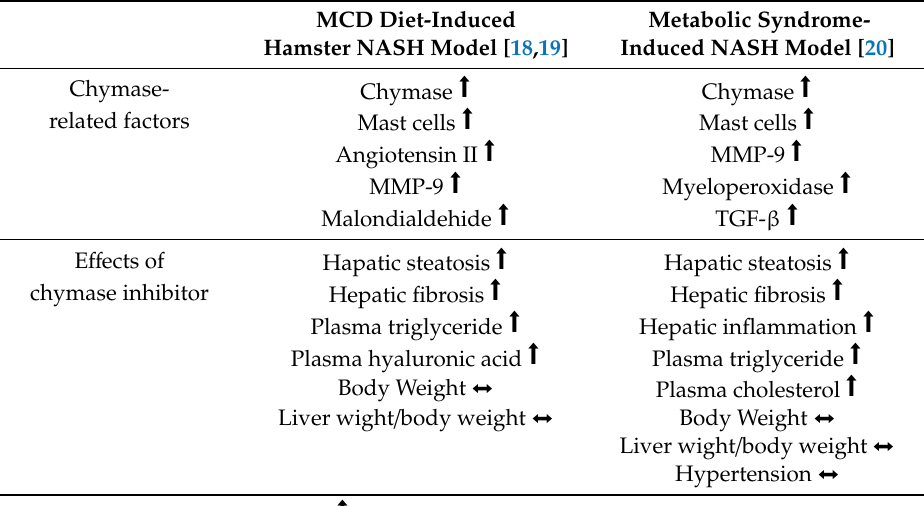
Table 2. Summary of experimental NASH models.